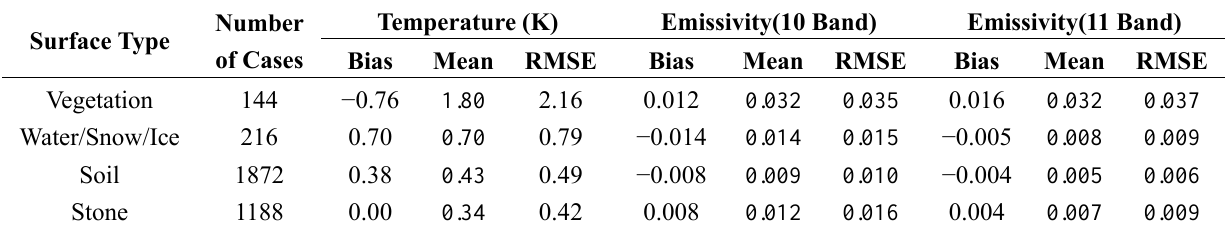
Table 4. Accuracy of the algorithm for different surface